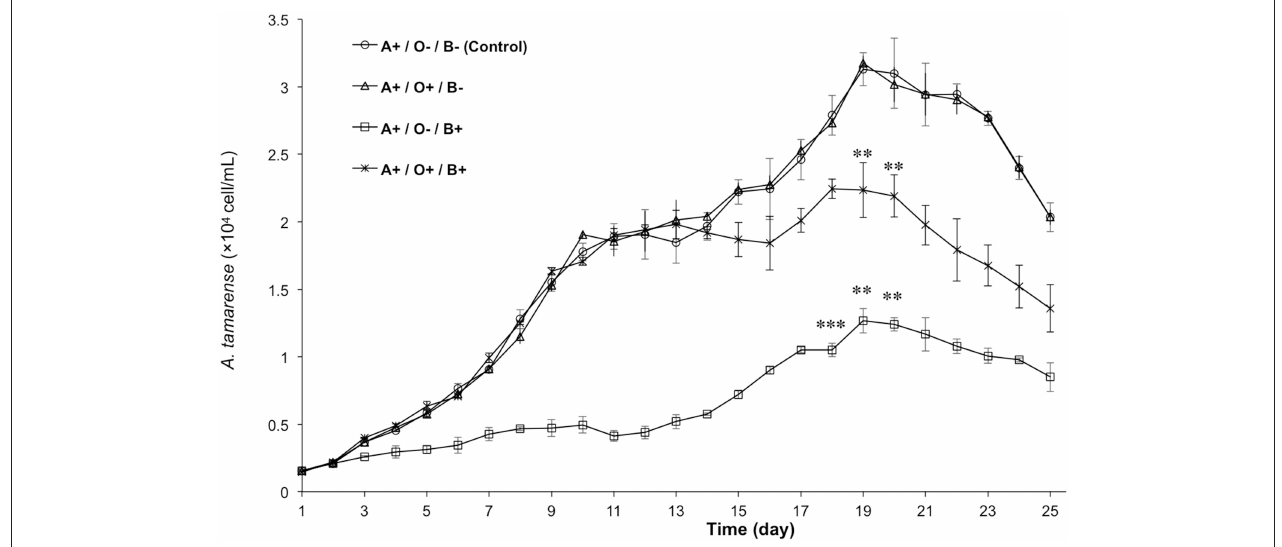
FIGURE 7 | The growth curves of A. tamarense under different effects of Ochromonas sp. and bacteria. “A” indicates A. tamarense ; “O” indicates Ochromonas sp.; “B” indicates bacteria; “ + ” indicates present; “ − ” indicates absent. The asterisks ** , and *** denoted statistical significance with p -values less than 0.01, and 0.001, respectively. All error bars indicate the SE of the three biological replicates.